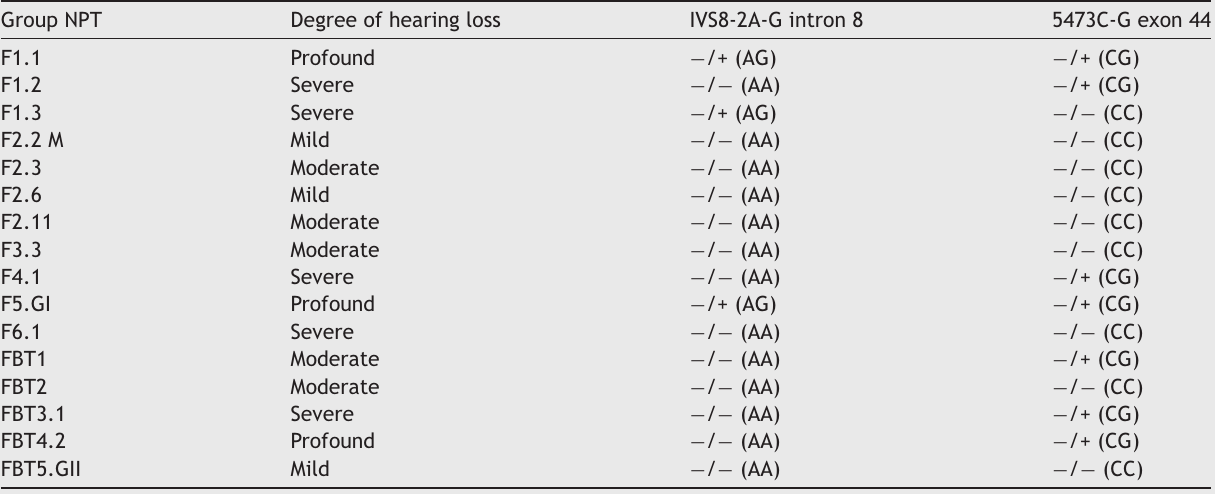
Degree of hearing loss and the genotypes found in Intron 8 and Exon 44 of the OTOF gene, in index cases of NPT group. Group